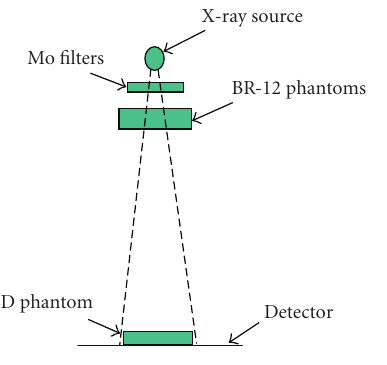
Figure 1: Schematic of spectra acquisition system.